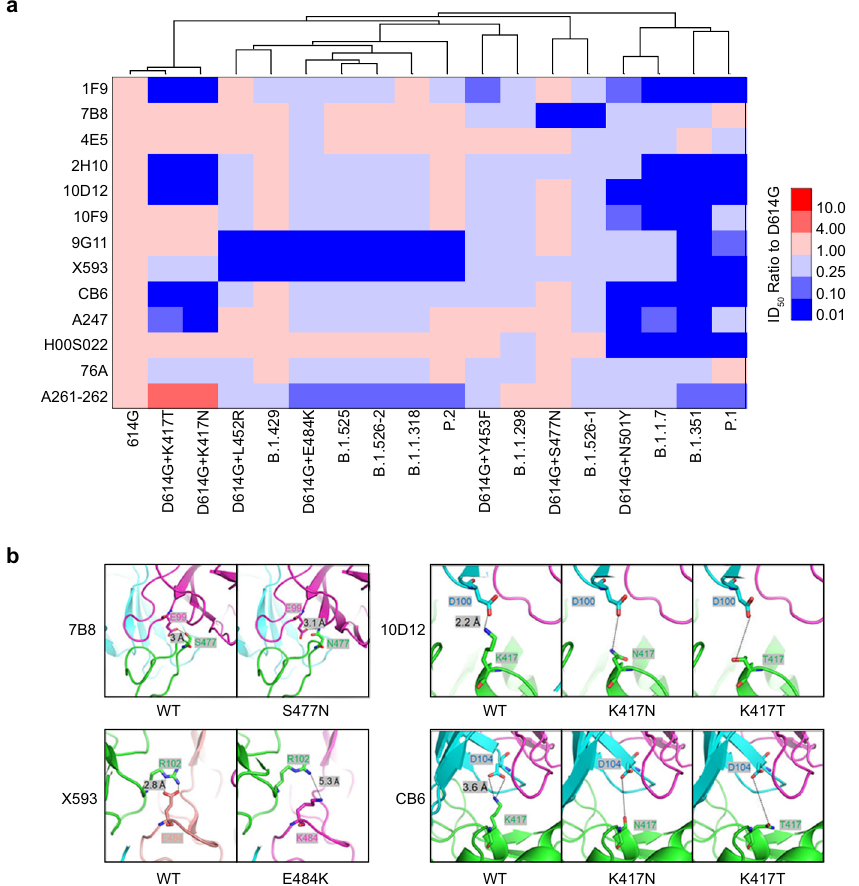
Fig. 4 Neutralization analyses of mAbs. a Thirteen mAbs were diluted serially and pre-incubated with pseudotyped SARS-CoV-2 variants at 37 °C for 1 h, then added to Huh-7 cell cultures. The heat map shows of mean ID 50 ratio compared with D614G. The results were obtained from three independent experiments. Red indicates increased neutralization activity and blue indicates decreased neutralization activity, as shown in the scale bar. b Structural modelling of the K417N/T, L452R, Y453F, S477N, E484K and N501Y mutations, based on 7chh for X593, RBD-7B8 for 7B8, RBD-Ab1 for 10D 12, and 7c01 for